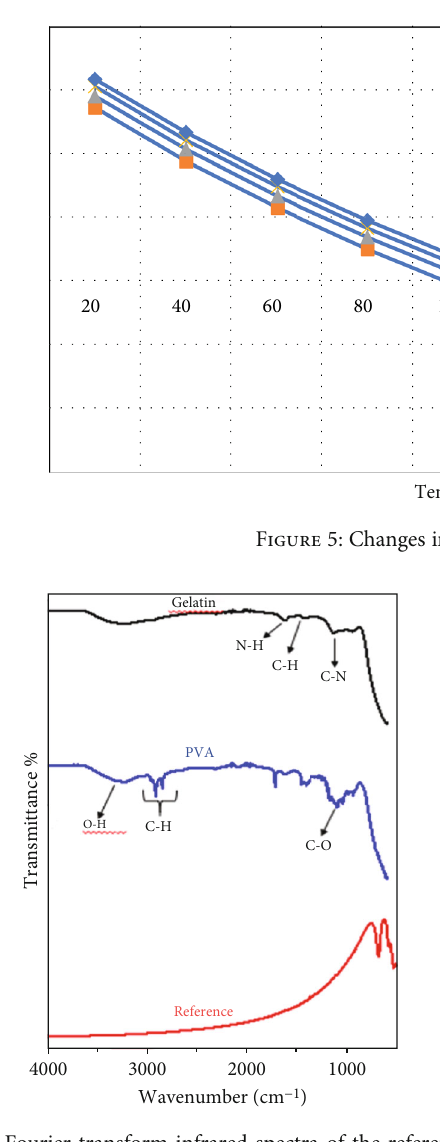
Figure 6: Fourier transform infrared spectra of the reference, the precipitate prepared in the presence of 100ppm PVA and